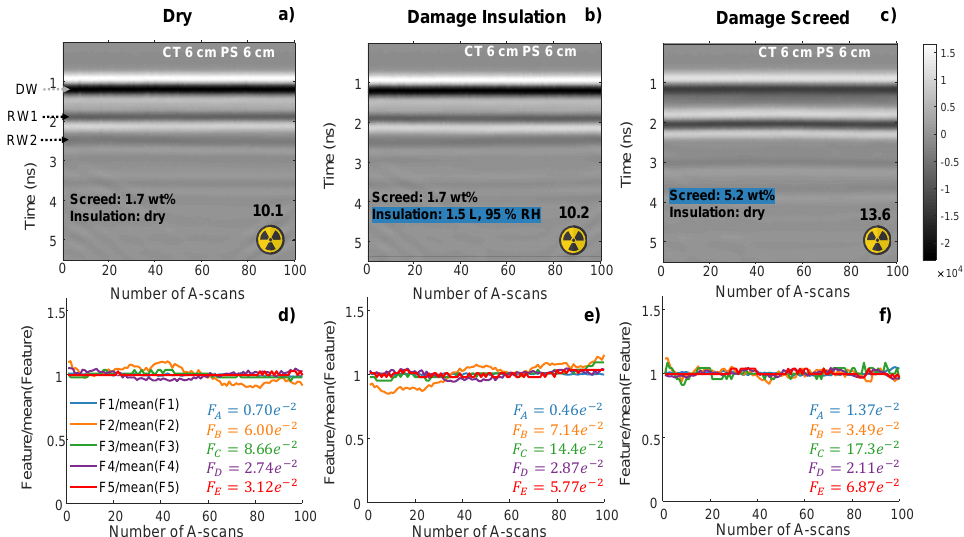
Figure 14. Measurements at a 6 cm CT and 6 cm PS floor construction for the scenarios: ( a ) dry, ( b ) damaged insulation, and ( c ) damaged screed. The bottom ( d – f ) shows the respective A-scan vector plots for each B-scan